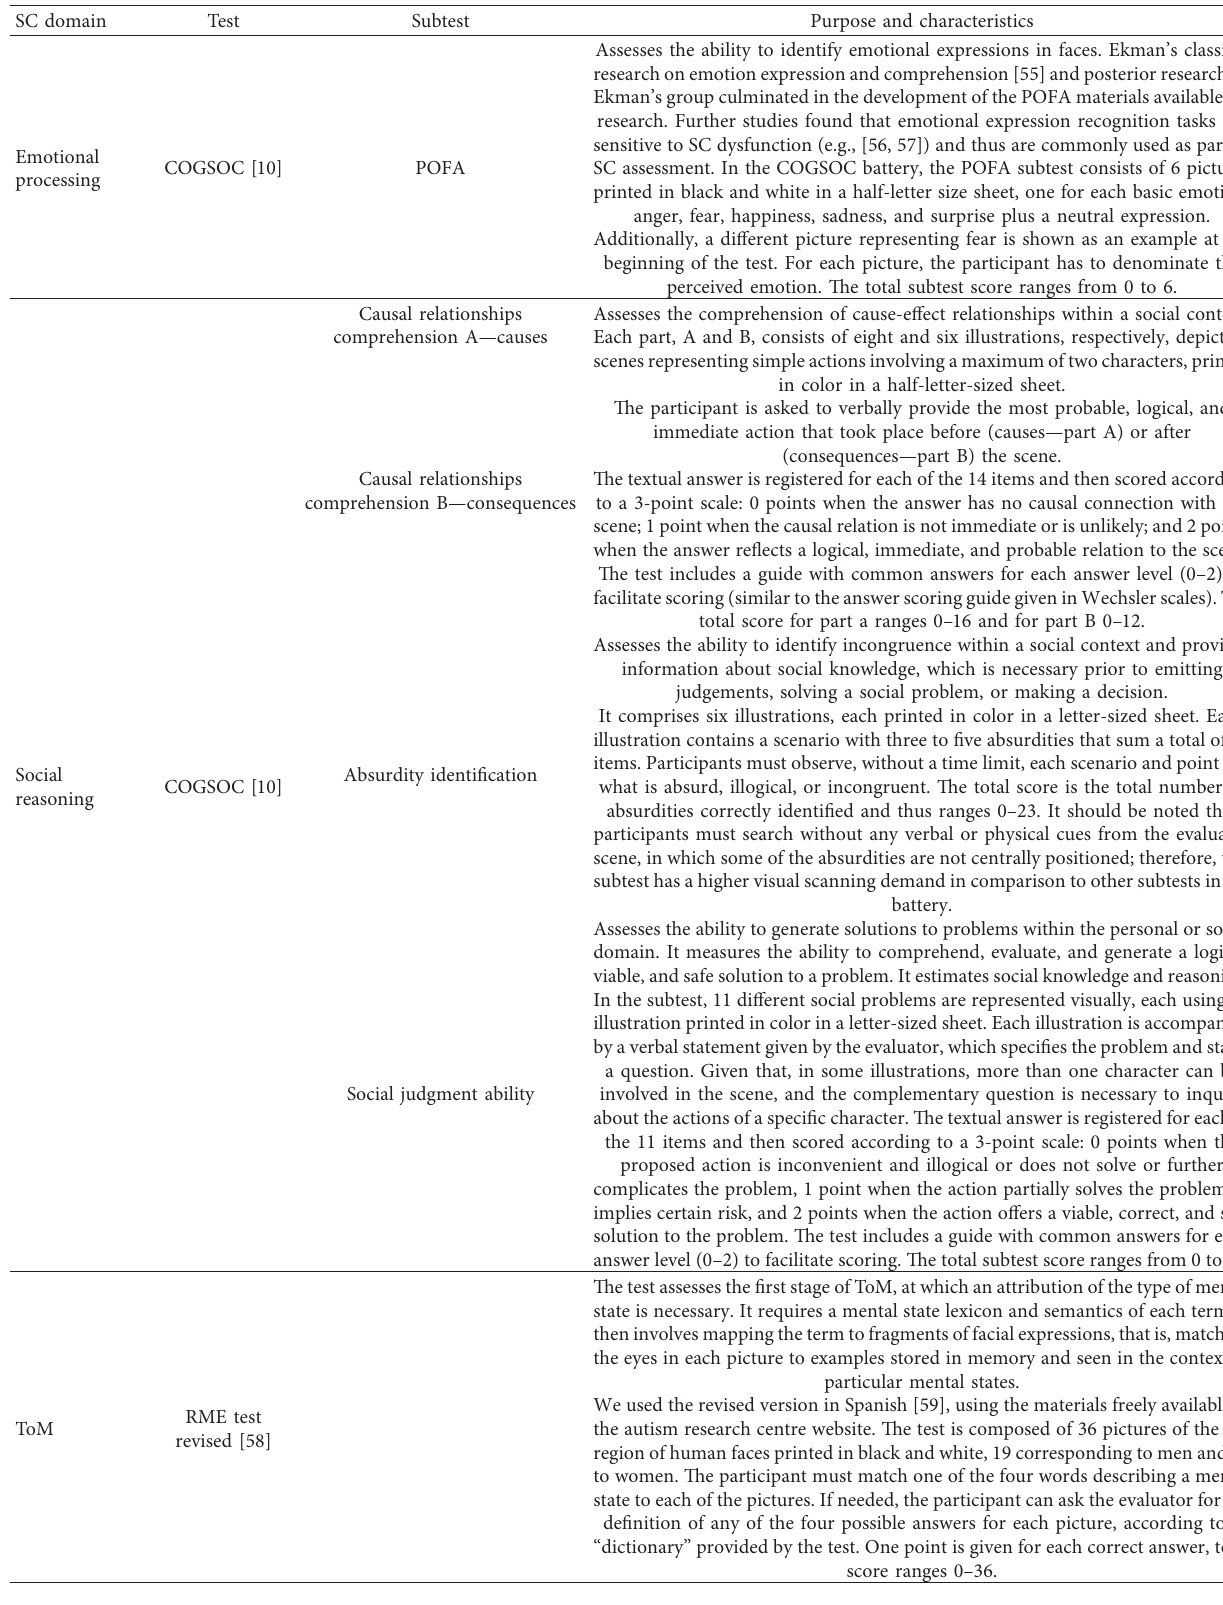
Table 1: Description of the assessment